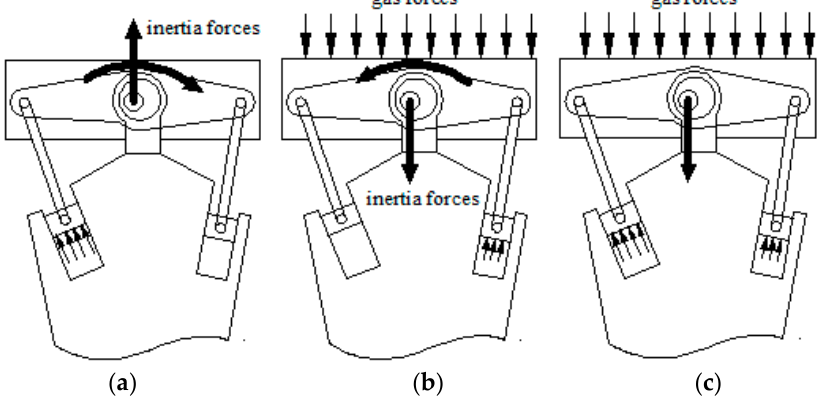
Figure 3. Schematic diagram of the adjustment process. ( a ) First stage of adjustment; ( b ) second stage of adjustment; ( c ) adjustment completion.